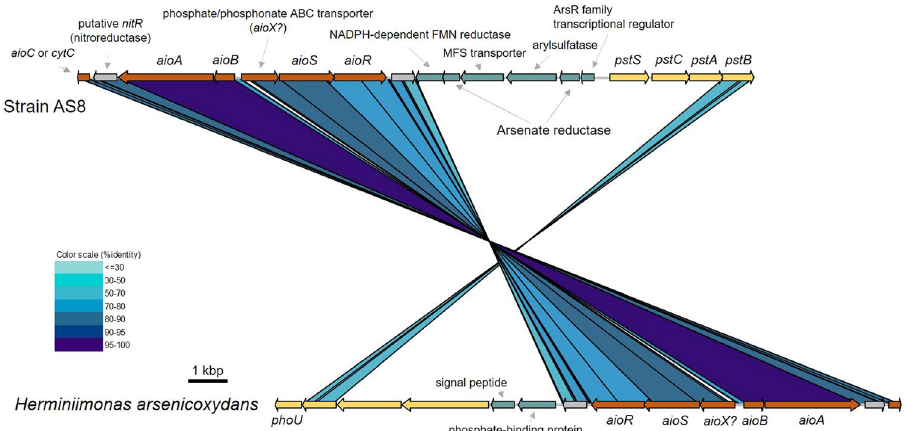
Figure 3. The comparison and organization of arsenite-related gene clusters identified in the AS8 and H . arsenicoxydans genomes. The homologous genes are connected by shaded regions, and the shading corresponds to percent identity, as determined by TBLASTX. The genes encoding hypothetical proteins are depicted in